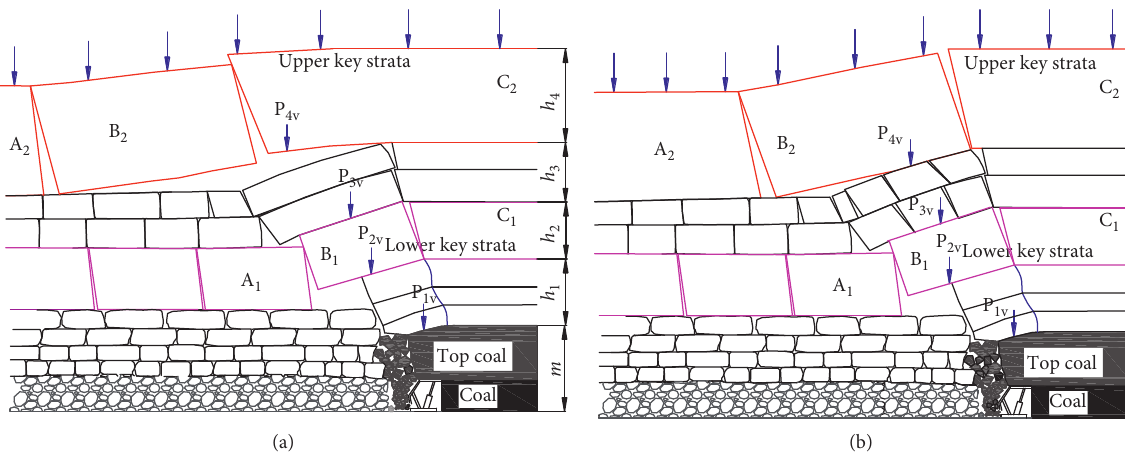
Figure 8: Modes of composite structure of lower and upper voussoir beam with hard main roof. (a) Instability of lower voussoir beam. (b) Synchronous instability of lower and upper